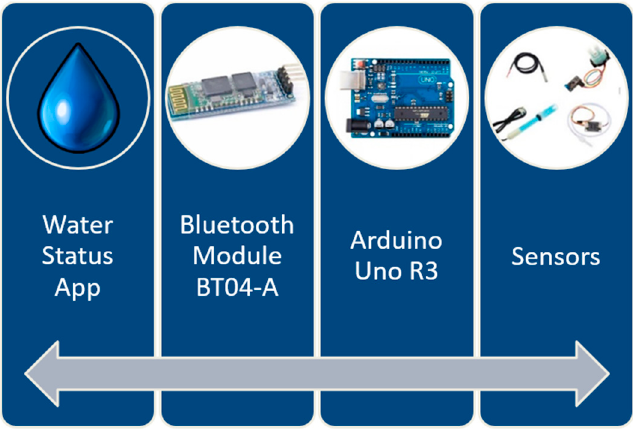
Figure 2. System architecture of the water status project.